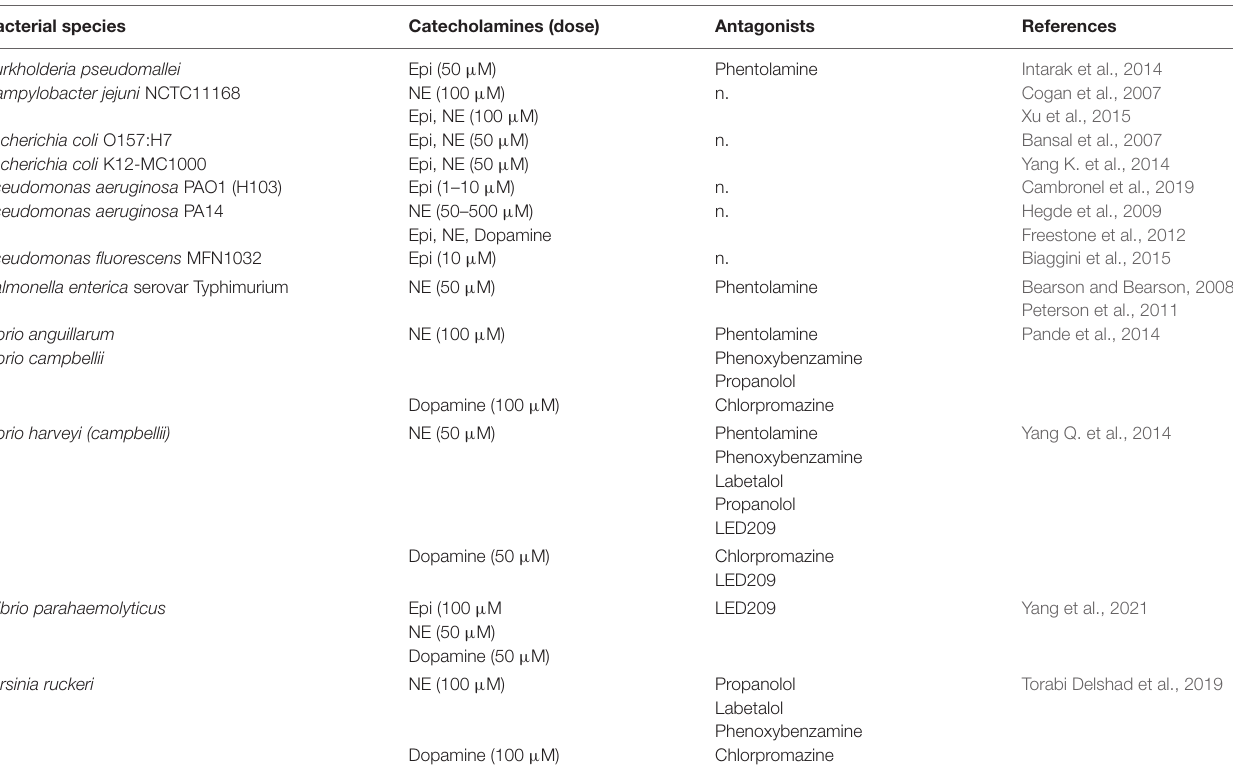
TABLE 3 | Bacterial motility and chemotaxis in presence of catecholamines. Bacterial